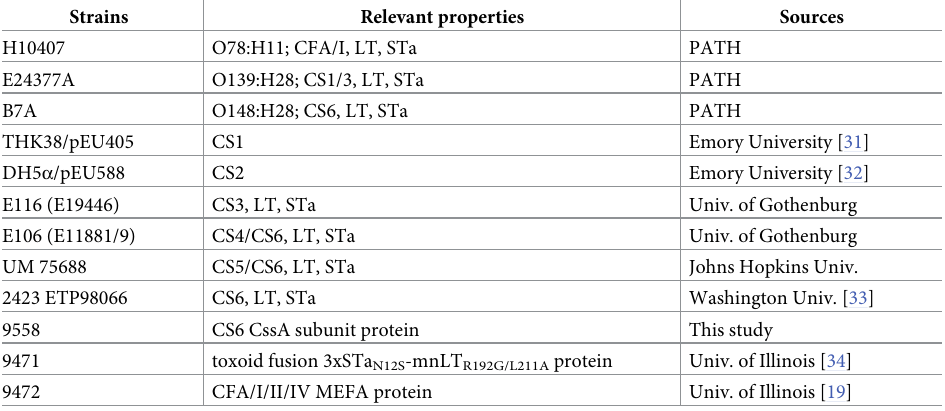
Table 1. Escherichia coli